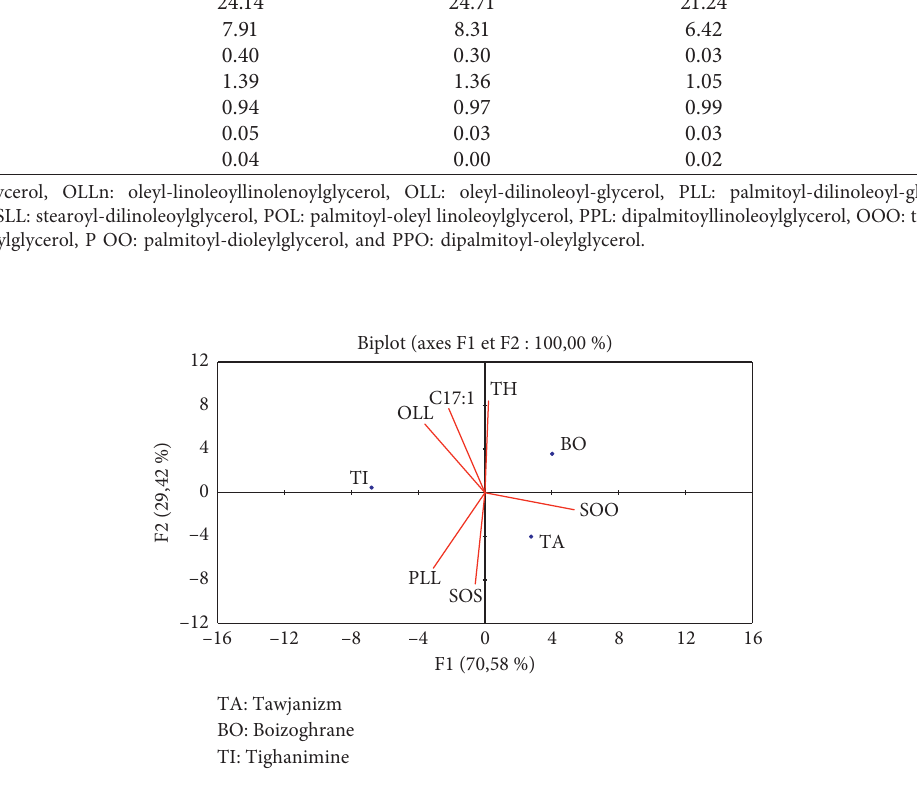
Figure 2: Correlation circle of variables according to PCA of the seed oil of Pistacia lentiscus and according to oil content fatty acid and triglyceride